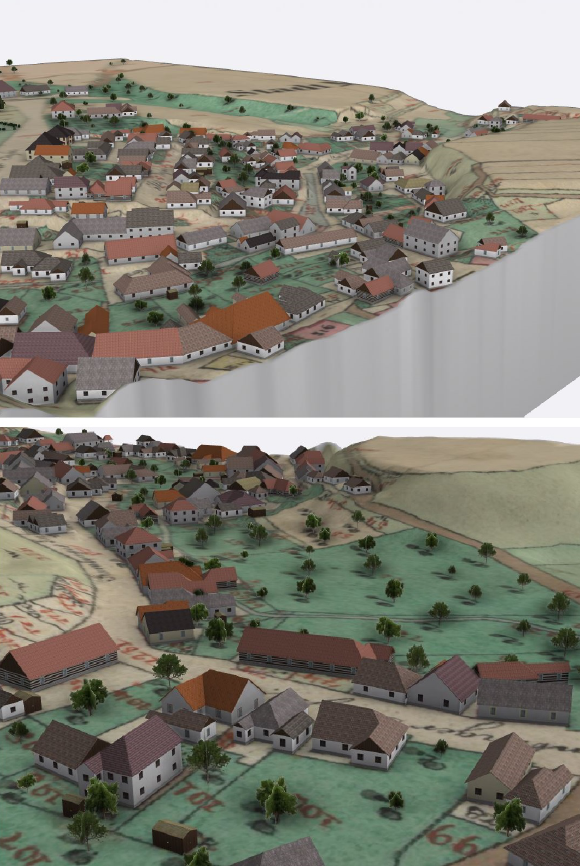
Figure 2. Semi-photorealistic 3D scene based on an old